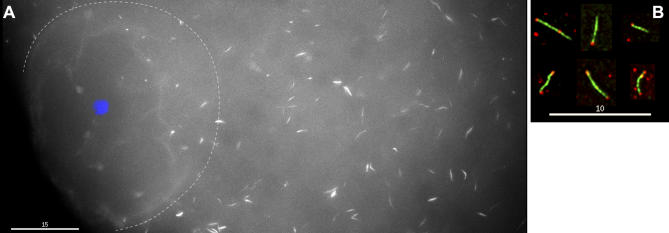
Polo-GFP Filaments Appear to Form at GVBD(A) A 60× image of a polo-GFP oocyte, apparently fixed in early GVBD. Note the germinal vesicle is still present (dotted outline), but with “ruffling” of the membrane, indicating the germinal vesicle is beginning to break down. Only GFP (grayscale) and DAPI (blue) are shown for clarity; Ald (Cy3) showed colocalization to filaments, and tubulin (Cy5) showed no detectable spindle formation around the oocyte nucleus. Short and relatively uniform Polo-GFP filaments are present throughout the cytoplasm, but not within the germinal vesicle. Those filaments within the dotted outline were in different focal planes than the membrane, and were clearly outside the germinal vesicle. When compared to most oocytes with filaments (compare to wild type in Figure 4C, and Polo-GFP in Figure 6B), the cytoplasmic filaments are much shorter (most well under 5 μm). (B) Individual filaments from a FM7/yw oocyte, apparently fixed during GVBD, stained with anti-Ald (green) and anti-BubR1 (red) antibodies. Note the very similar lengths of the filaments and the presence of BubR1 foci at the tips of the Ald filaments.